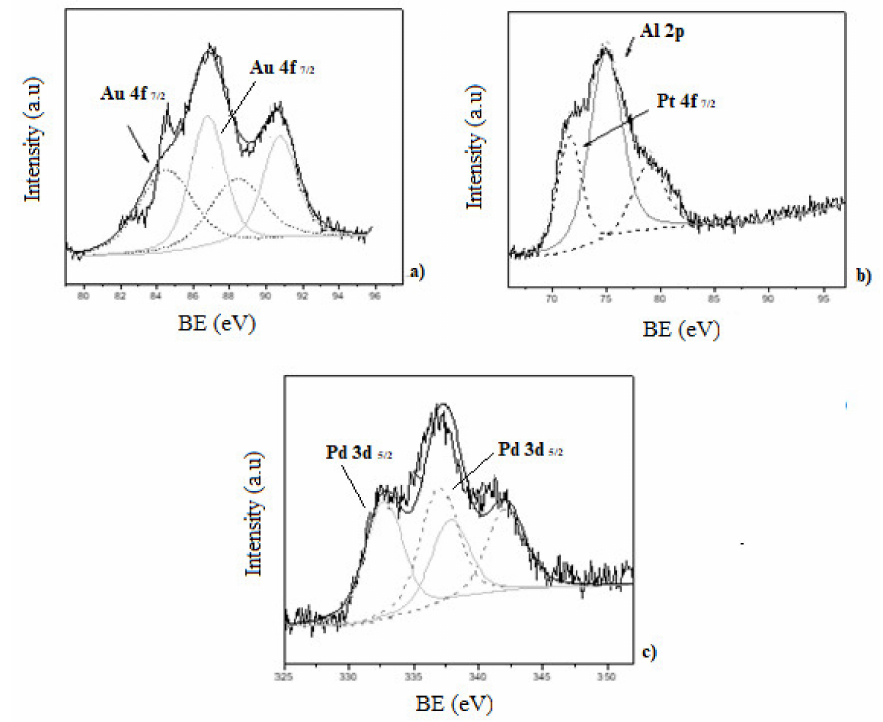
Figure 5. X-ray photoelectron spectroscopy (XPS) spectra of the monometallic catalysts; ( a ) Au-ZSM- 11; ( b ) Pt-ZSM-11; ( c ) Pd-ZSM-11.